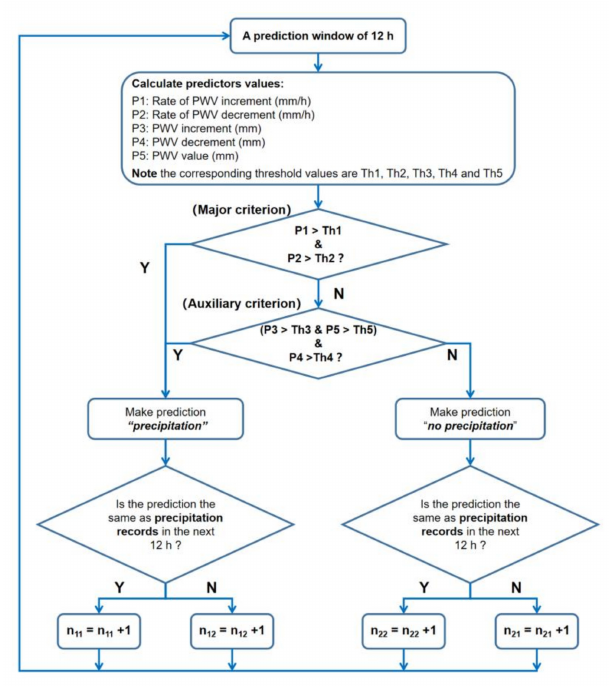
Figure 6. Flowchart for new model